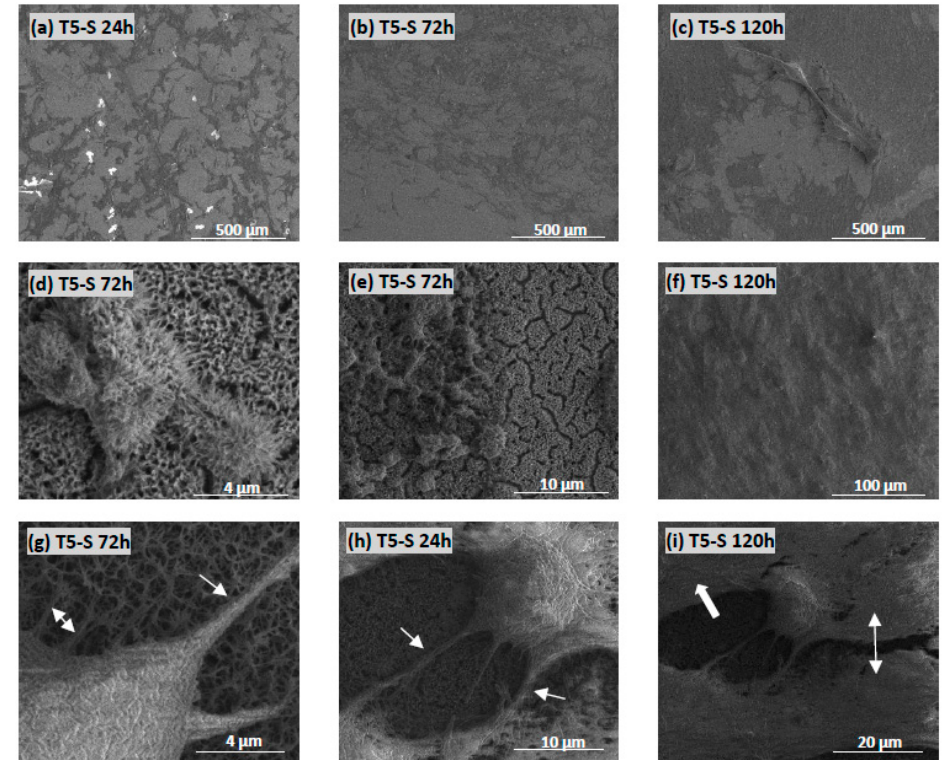
Figure 13. Micrographs obtained by SEM showing MG-63 osteoblast-like cells cultured on the T5-S specimens for 24 ( a ), 72 ( b ), and 120 h ( c ). Figures ( d – f ) indicate that the MG-63 cells are morphologically similar to the structure of T5-S samples. Arrows in the micrographs present filopodia which attached the cell to the substrate ( g ) or the filopodia created between the cells ( h ). Figure ( i ) indicates the extracellular matrix produced by osteoblast-like cells.